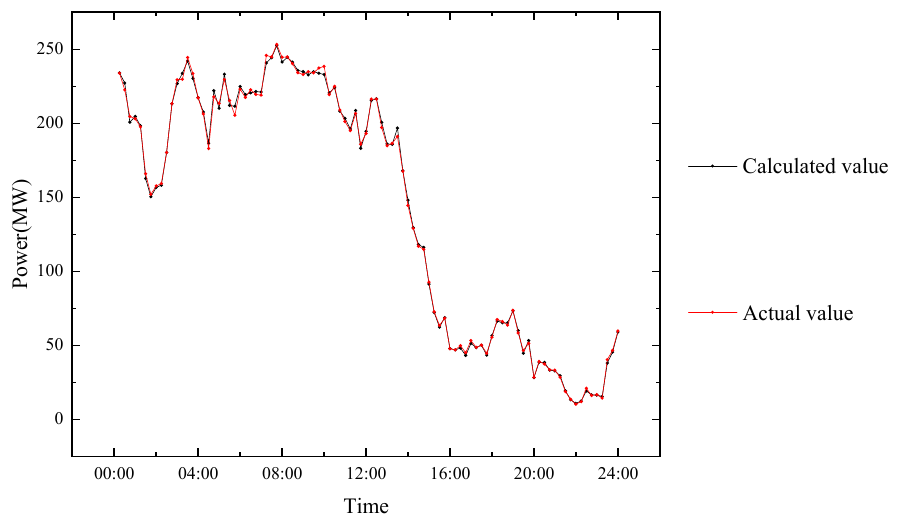
Figure 13. Calculation results of mapping from wind turbine clustered power to collector system power.